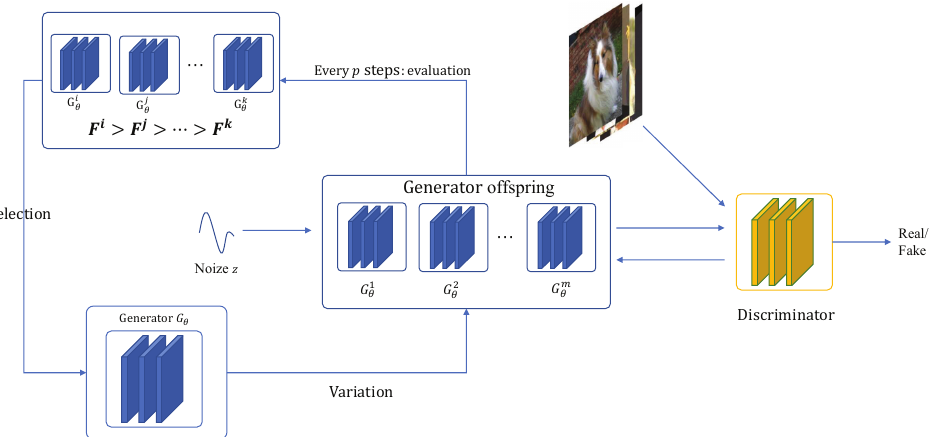
Figure 1. The framework of PEGANs. A generator will produce some offspring that will use different objective functions as update strategies. The discriminator needs to play against several generators at a time. At every certain training interval, the fitness of the generator offspring is evaluated, and the outstanding individuals will be retained and enter the next round of